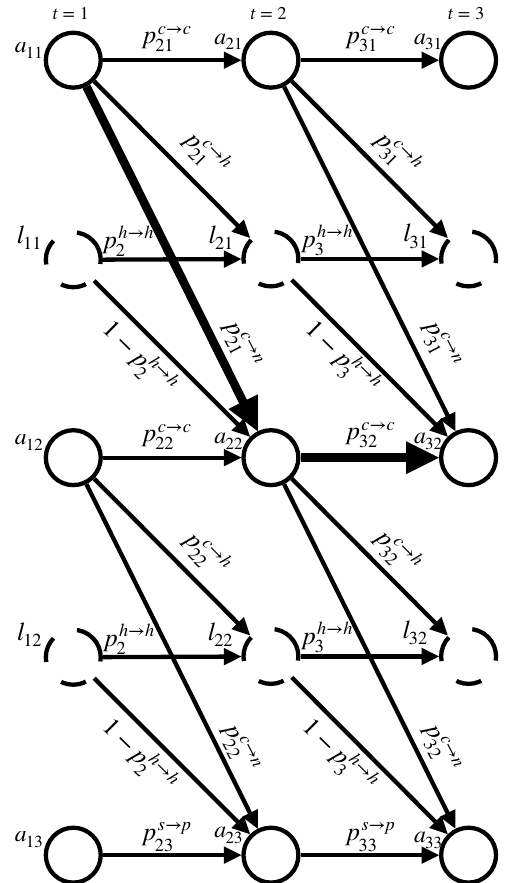
Figure 2. Schematic diagram of SSMA with t ∈ { 1,2,3 } and n ∈ { 1,2 } . The dashed circles denote hidden states at each decoding step. The definitions of the symbols in this figure can be found in Section